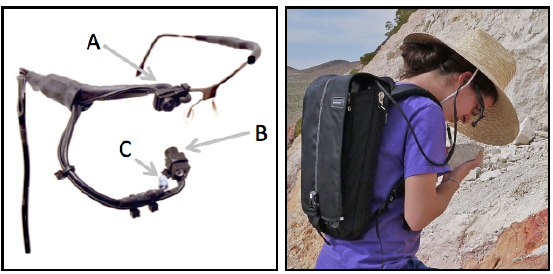
Figure 2. Eye-tracking system used in our research. Headgear consists of a color camera (A) to capture the scene in front of the observer, a monochrome camera (B) pointing towards the right eye for monocular tracking, and a near- infrared emitting diode (C) to illuminate the eye image and provide a first-surface corneal reflection. At right is an observer wearing the headgear and